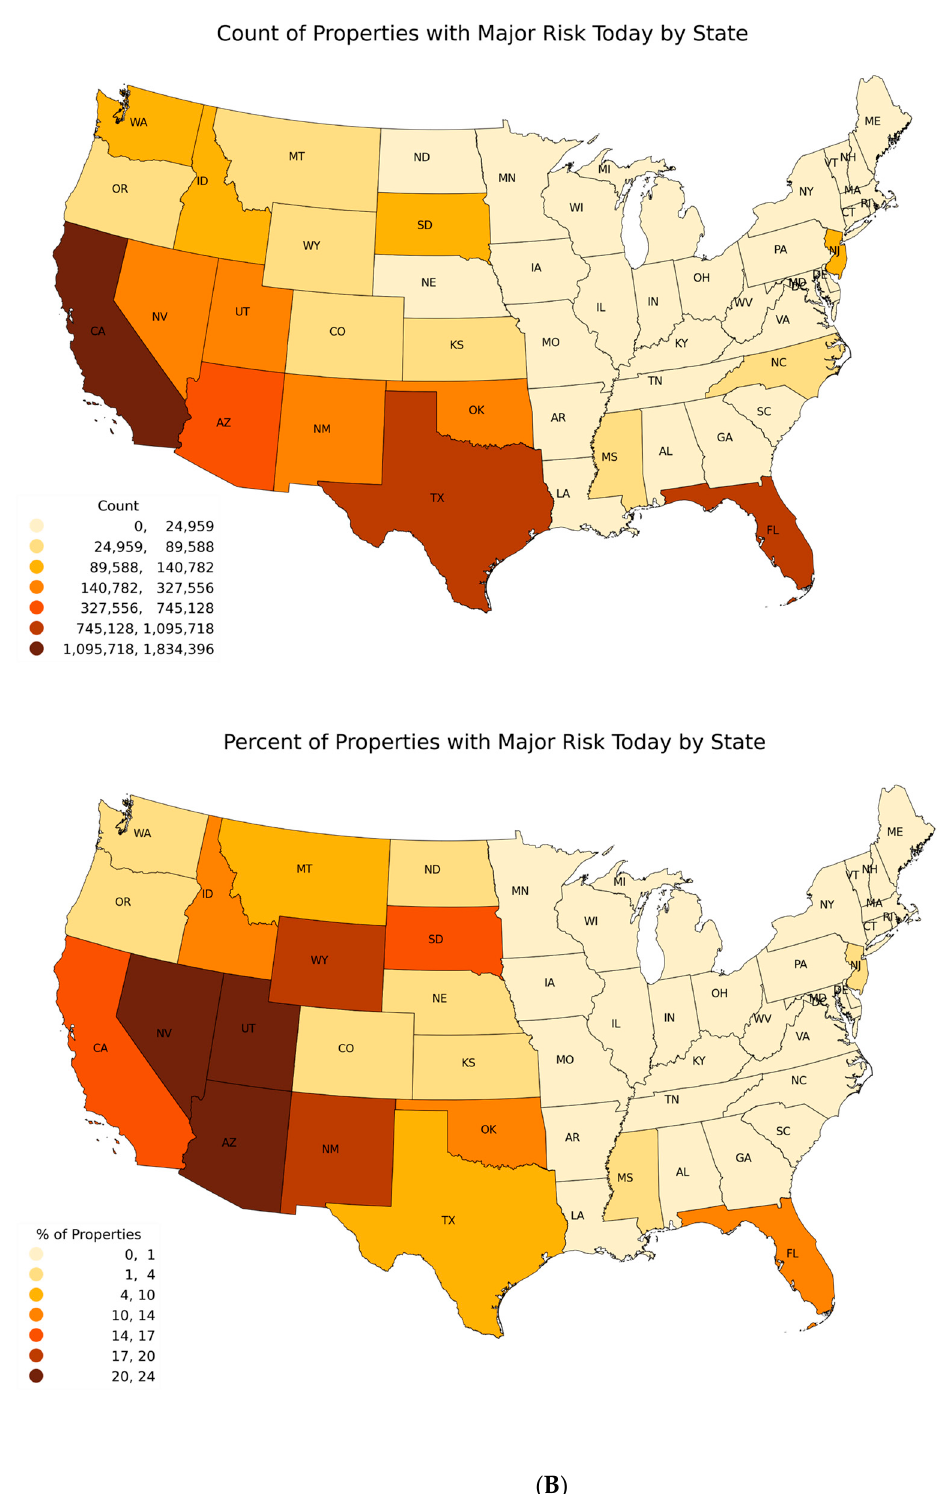
Figure 12. ( A ) Geographic distribution of “any exposure” to wildfire (>1% cumulative exposure): those individual properties with >1% cumulative exposure over 2022–2052 were counted on a state by state basis, and compared to the total number of all properties. ( B ). Geographic distribution of “major exposure” to wildfire (>3% cumulative exposure): those individual properties with >3% cumulative exposure over 2022–2052 were counted on a state by state basis, and compared to the total number of all